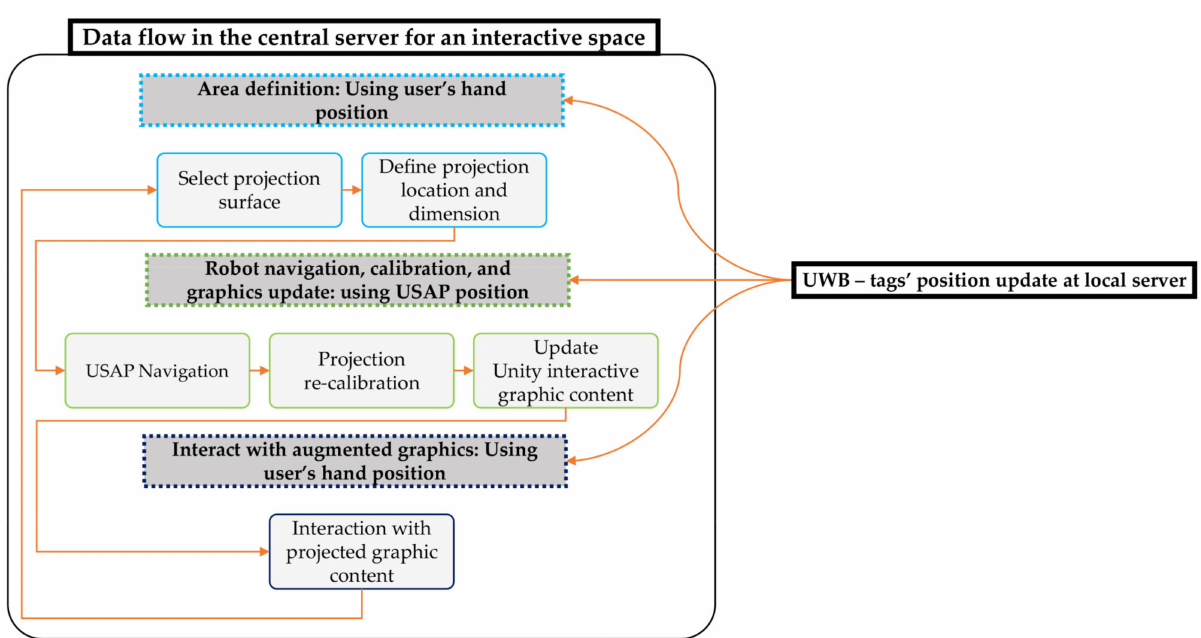
Figure 7. Data flow inside the central server for an interactive